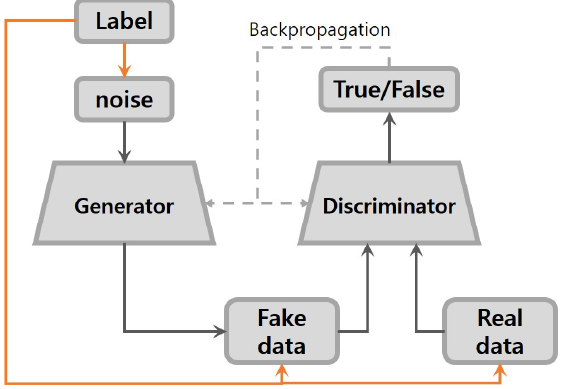
Figure 2. Architecture of conditional